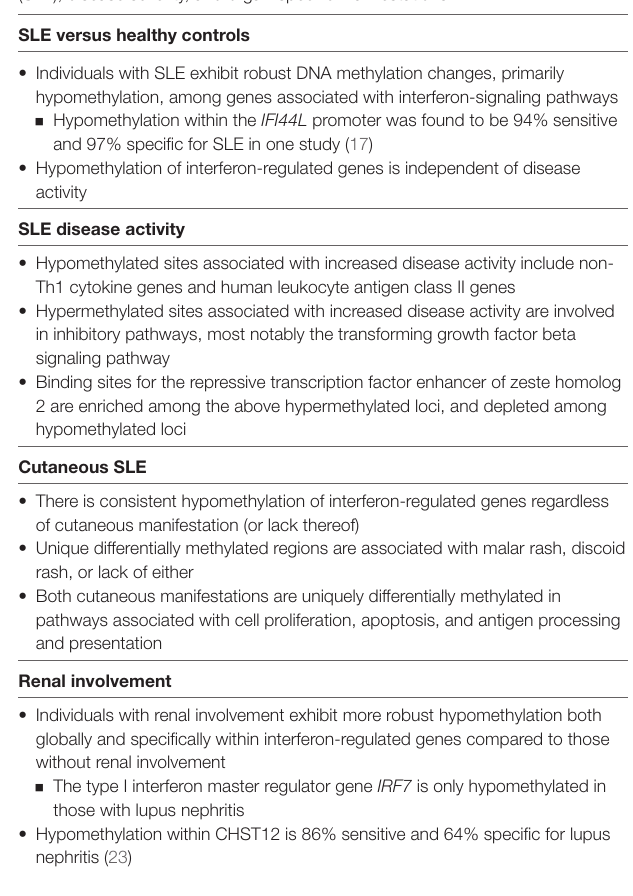
(SLE), disease severity, and organ-specific